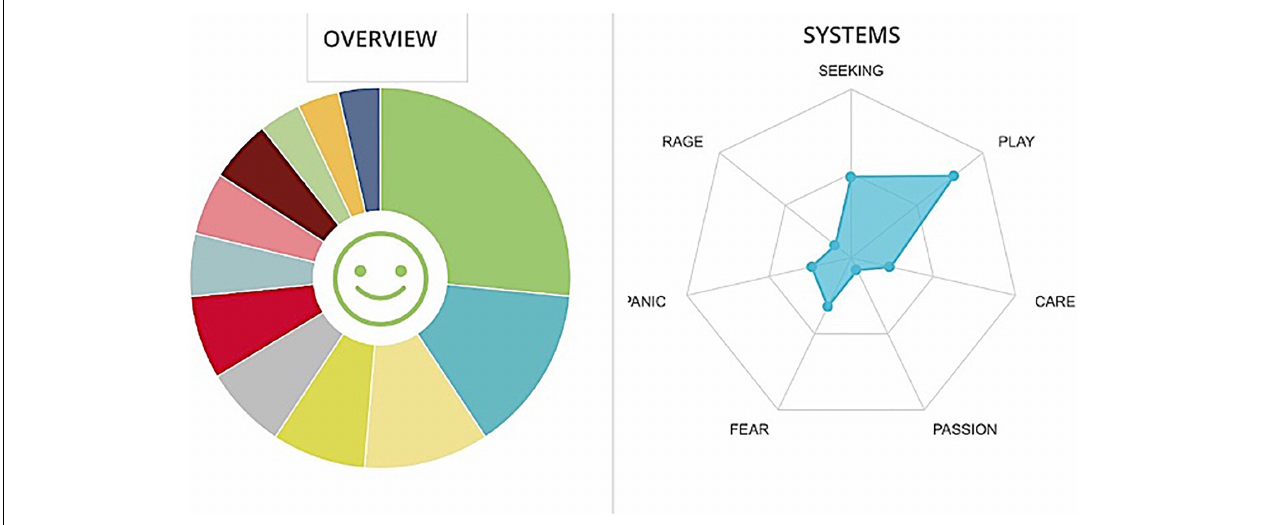
FIGURE 9 | Graphs GC. The cumulative percentages of choice of emotions made by a team are represented in the pie chart (Different colors match to the different emotions as they are displayed in Figure 1 ) while the web graph shows the correspondence between chosen emotions and emotional systems.